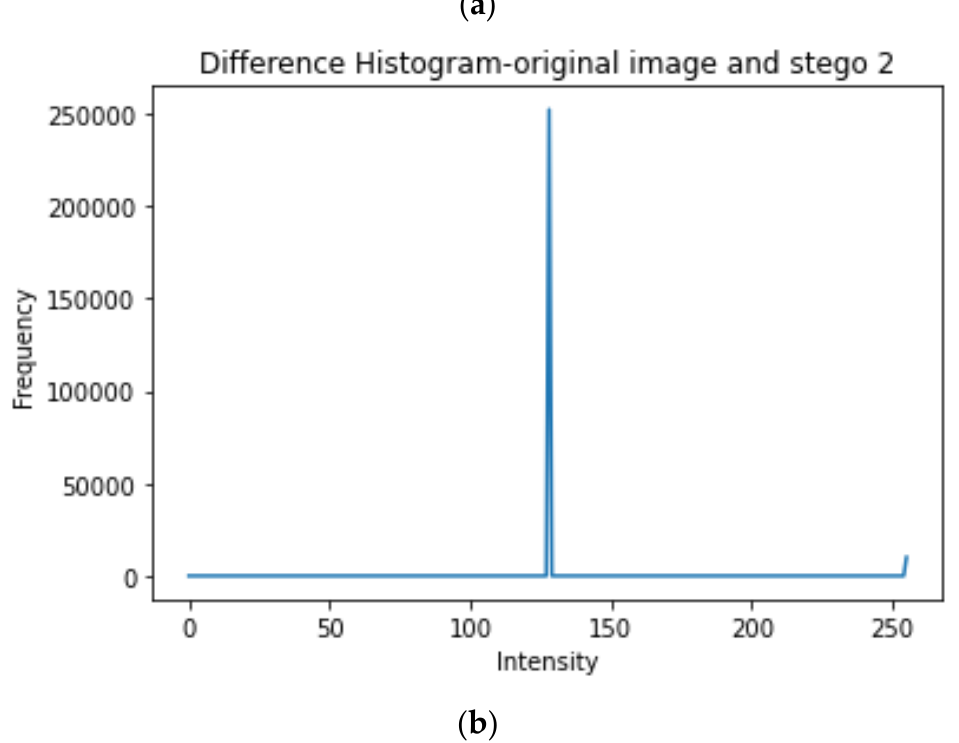
Figure 10. Difference histograms. ( a ) Stego image 1 and original image difference histogram. ( b ) Stego image 2 and original image difference histogram.